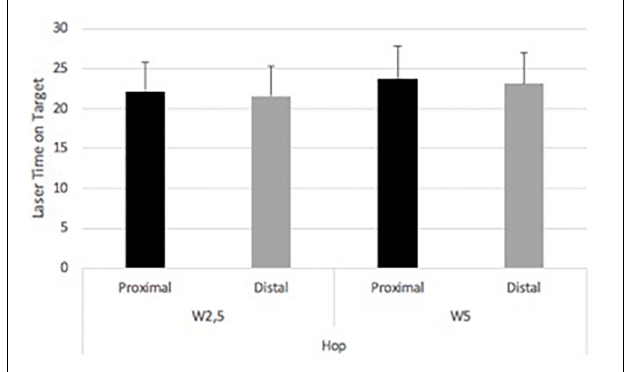
FIGURE 6 | Experiment 2. Laser time on target within foci between wall distances in the hop task.